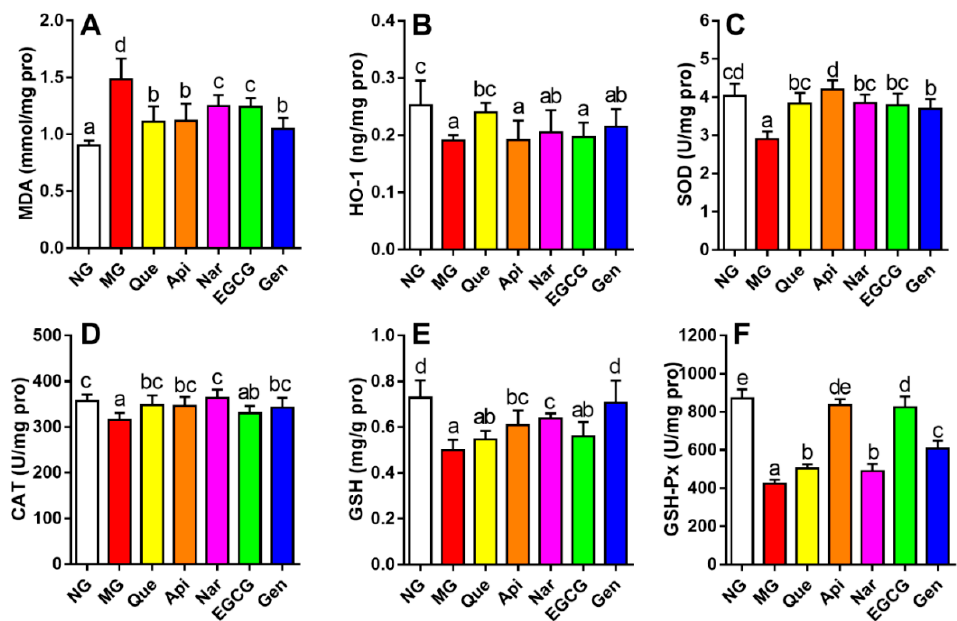
Figure 4. Effect of five kinds of flavonoids on hepatic lipid peroxidation and oxidative stress: ( A ) malondialdehyde level; ( B ) heme oxygenase 1 level; ( C ) superoxide dismutase activity; ( D ) catalase activity; ( E ) glutathione activity; ( F ) glutathione peroxidase activity. Values are expressed as the mean ± SD ( n = 10). Labeled means without a common letter differ ( p < 0.05). NG, normal group; MG, model group; Que, quercetin; Api, apigenin; Nar, naringenin; EGCG, epigallocatechin gallate; Gen, genistein.